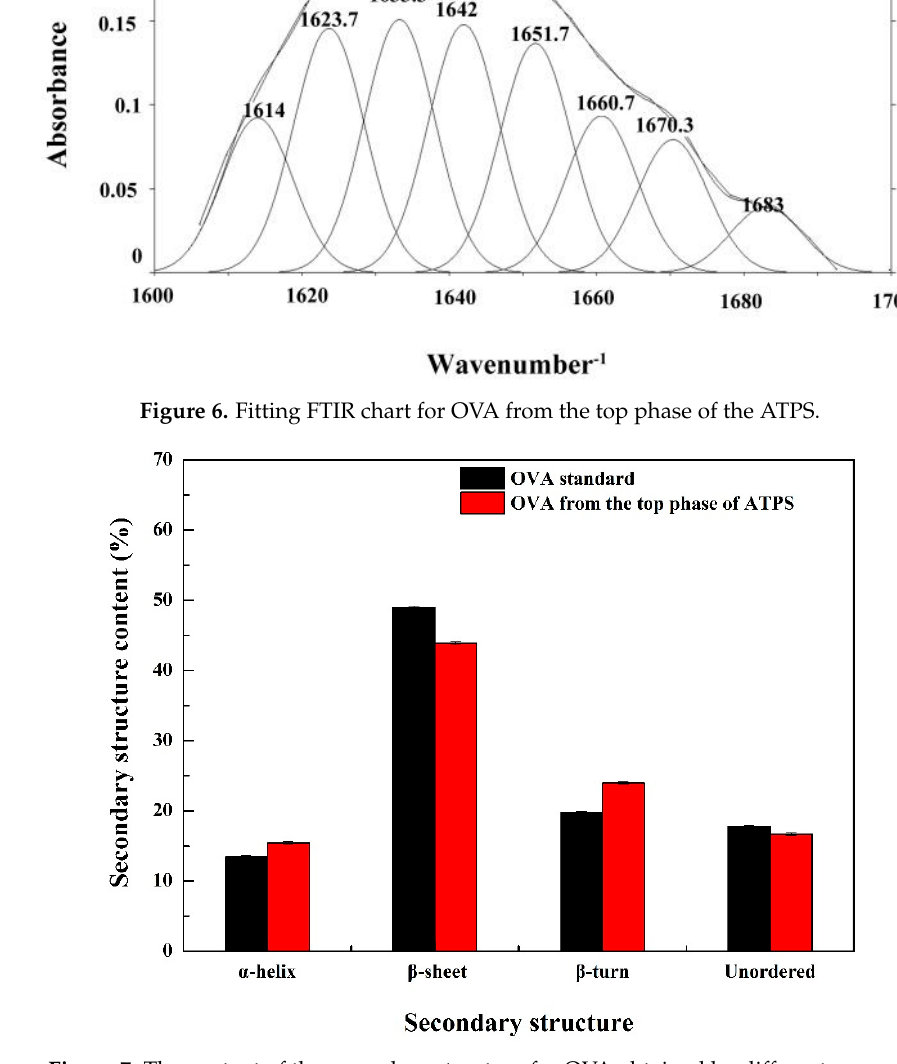
Figure 7. The content of the secondary structure for OVA obtained by different sources.